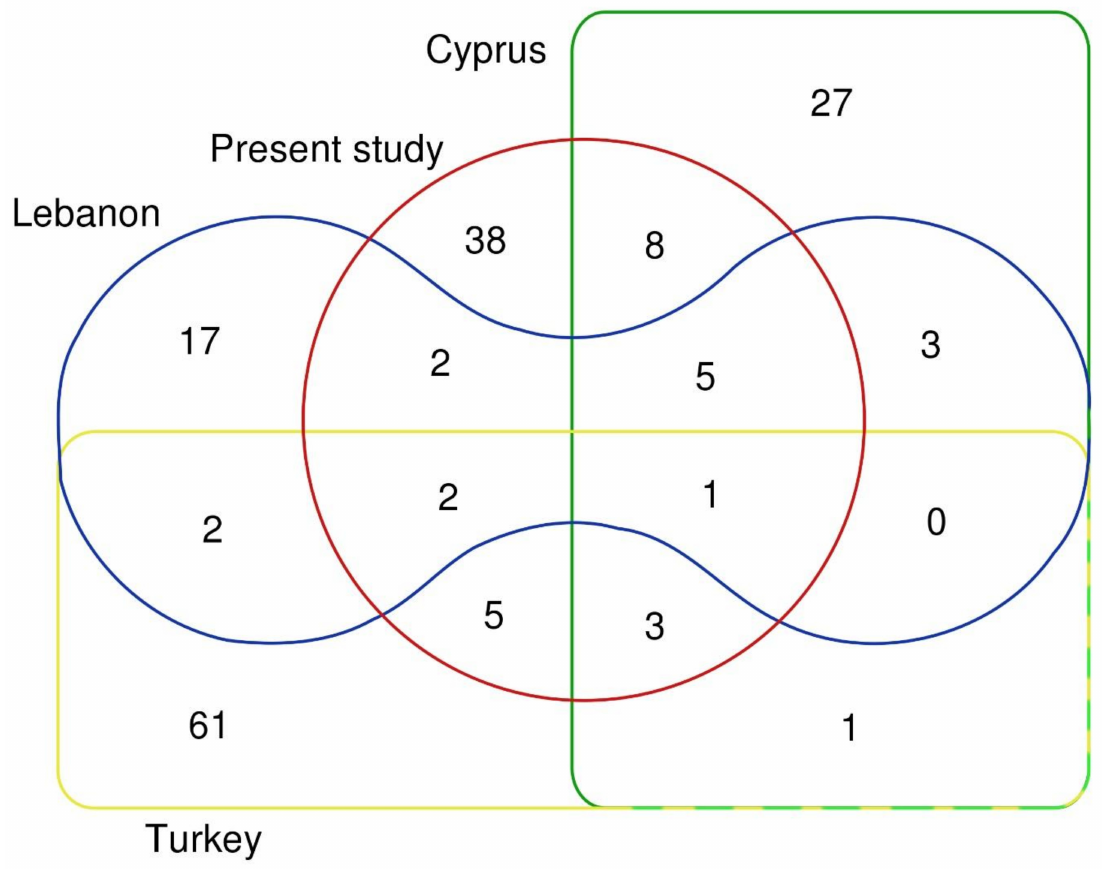
Figure 3. Overlap of used wild food plants between our study and selected studies from some East Mediterranean countries (numbers refer to the overlapping